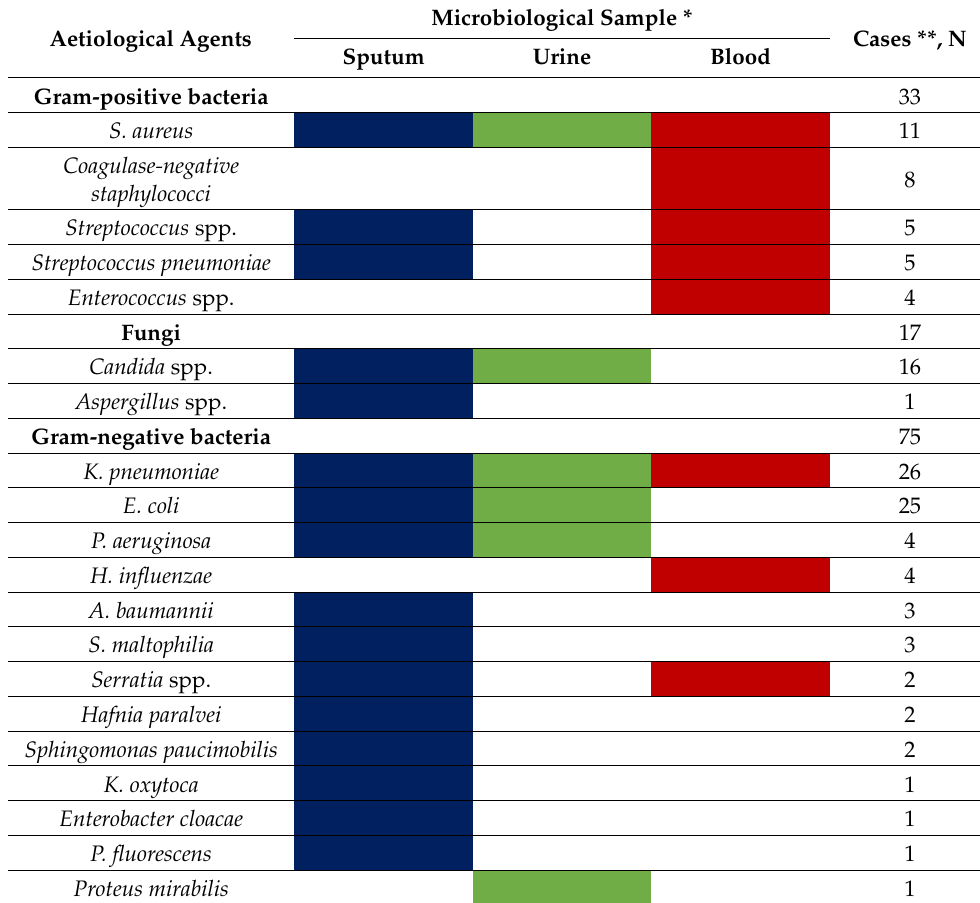
Table 1. Epidemiology of microbiological documented associated